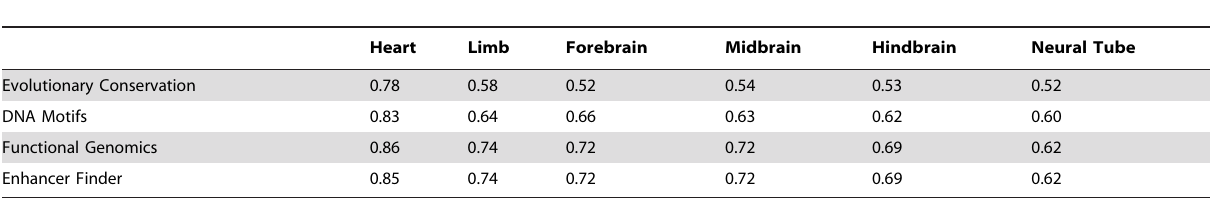
Table 1. Performance (ROC AUC) of classifiers on each tissue-specific enhancer prediction task (Step 2).